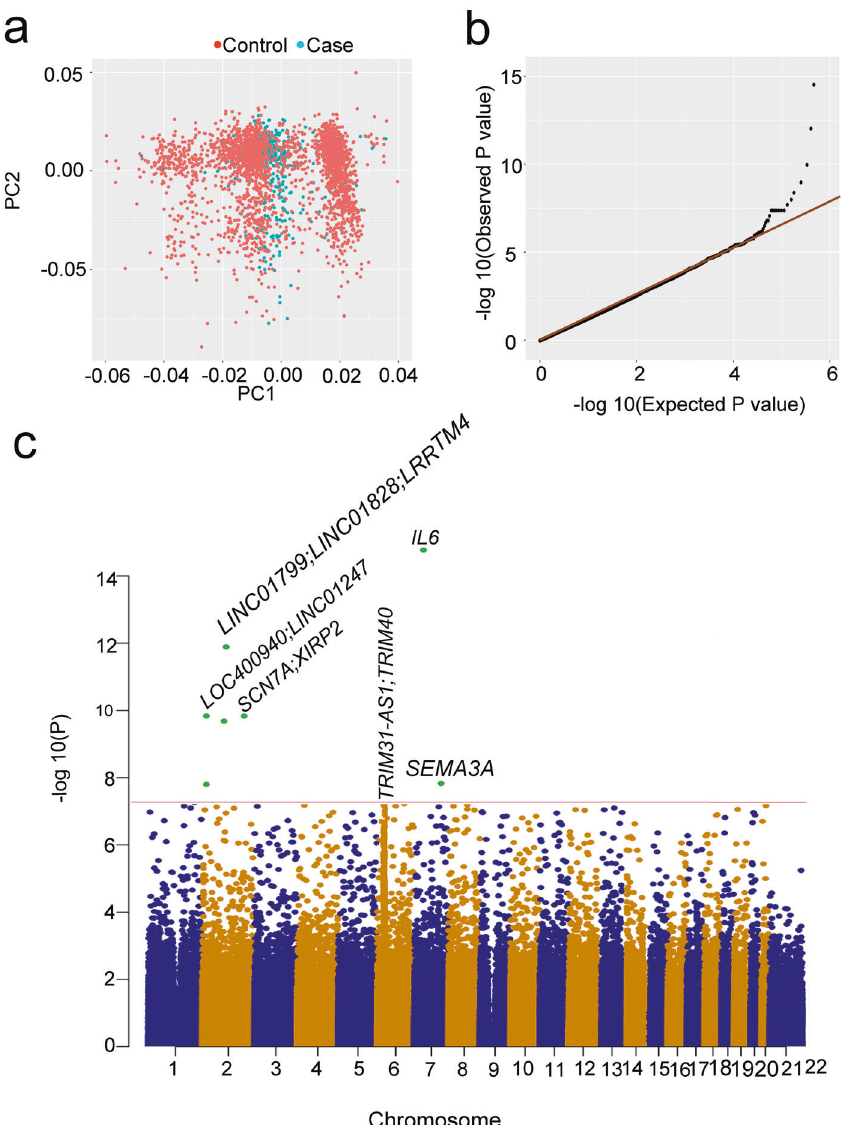
Fig. 1 Summary of GWAS results. a Principal component analysis (PCA). b The quantile-quantile (Q-Q) plots of the GWAS results. c Nine loci surpassed genome-wide signi fi cance ( P < 5 × 10 − 8 ) in the combined of discovery and replication